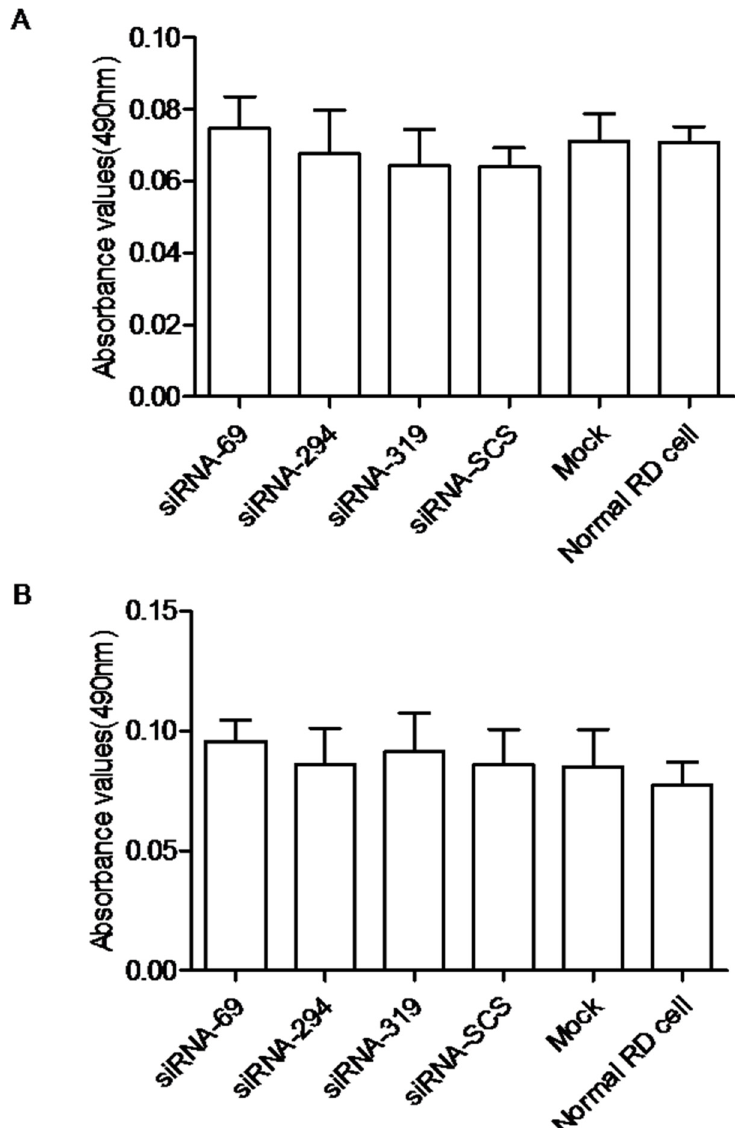
Fig 8. Interferon pathway was not activated by siRNA. The levels of IFN- α (A) and IFN- β (B) were determined by measuring the absorbance at 490 nm. The data shown represent the means ± SD of three independent